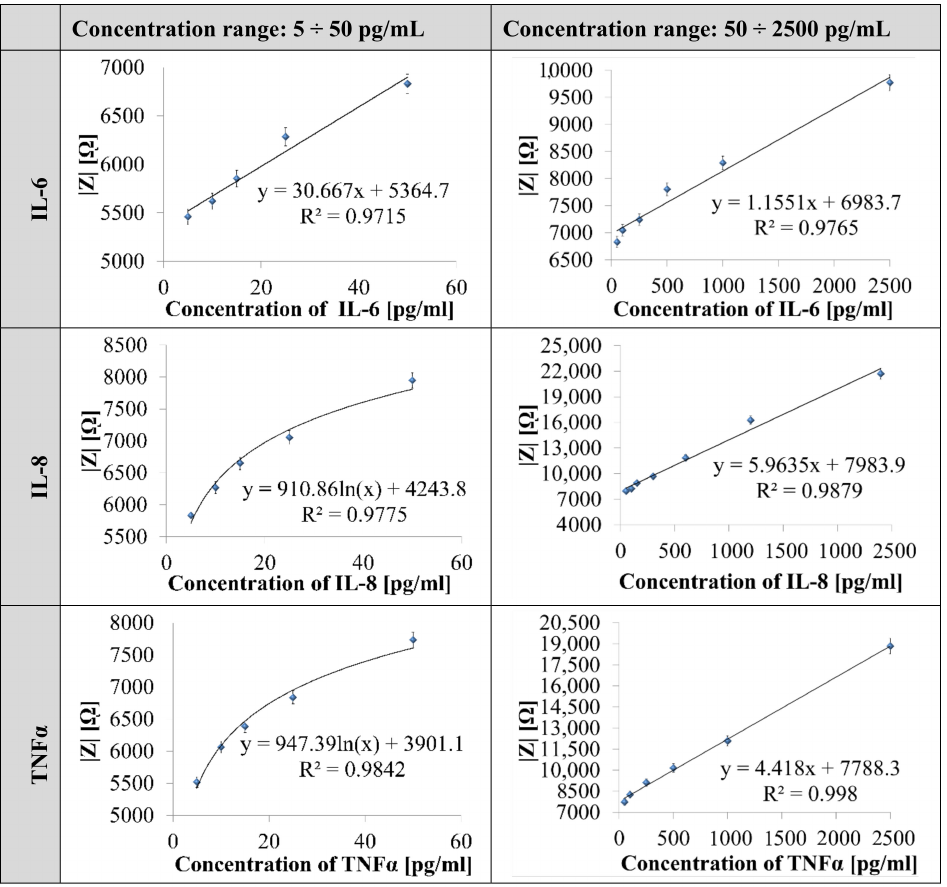
Figure 5. Calibration curve obtained between | Z | and concentration of IL-6, IL-8, and TNF α measured in 0.1 Hz frequency.